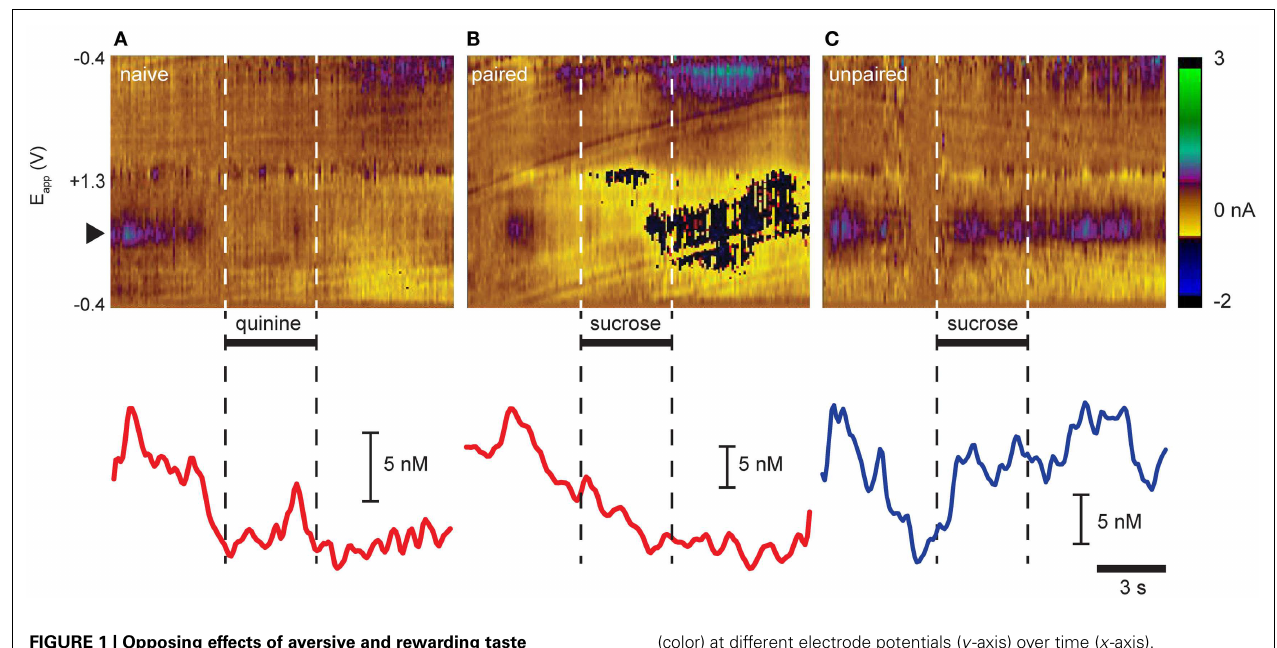
FIGURE 1 | Opposing effects of aversive and rewarding taste stimuli on dopamine release in NAc shell. Representative trial examples resulting from intra-oral infusions of (A) quinine in naïve rats, (B) sucrose in rats that had experienced sucrose explicitly paired with LiCl-induced malaise, and (C) sucrose in rats that did not have sucrose paired with malaise. Color plots (top panels) show changes in current